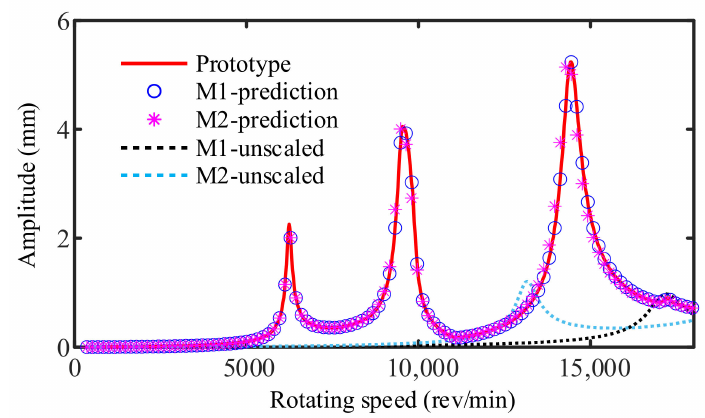
Figure 17. Prediction of AFR from M1 and M2 under